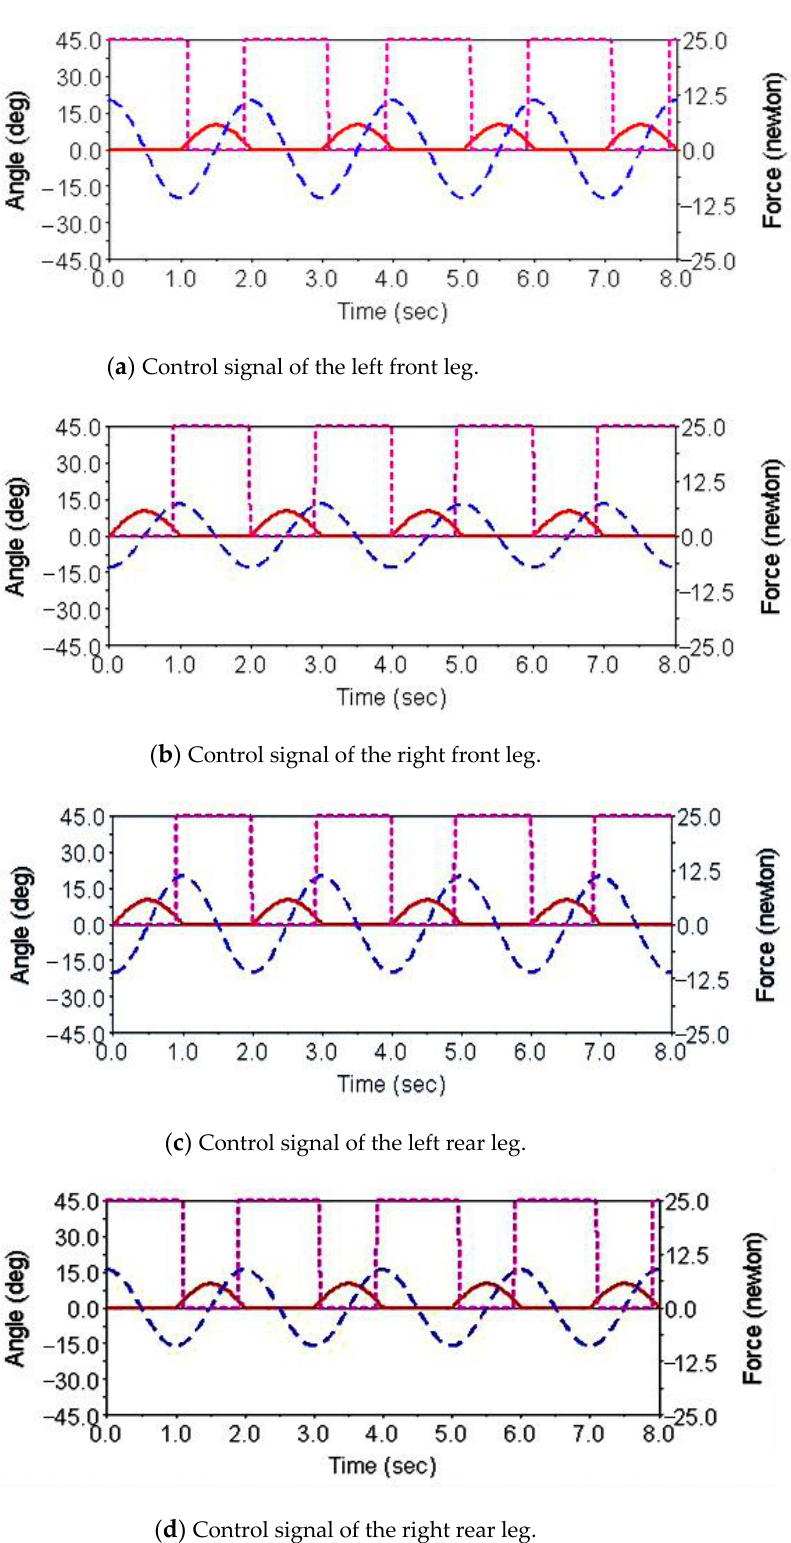
Figure 7. Diagonal gait for turning motion in ADAMS.